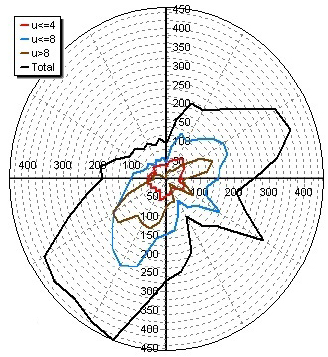
Figure 1. Wind rose of Trainou station (180m) for four different wind classes calculated with Trajectory Viewer 1.1 developed at ECN (Energy Research Centre of the Netherlands, http://www.ecn. nl/) and from model FLEXTRA (Stohl et al., 2005) for the year